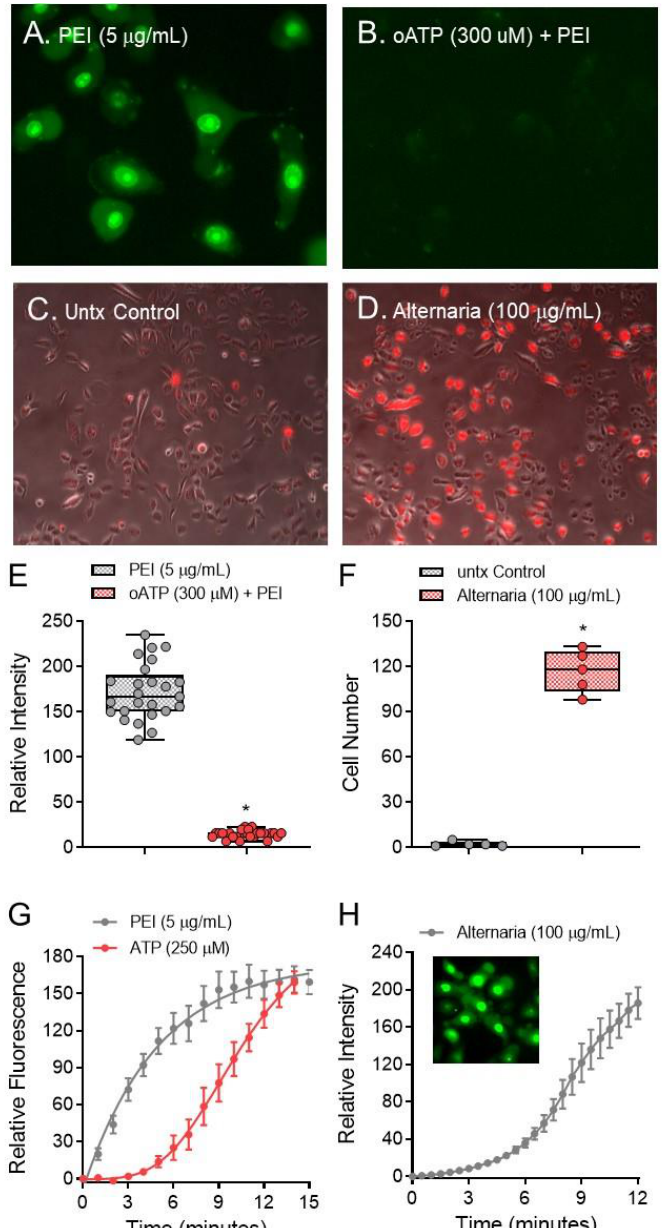
Figure 3. Yo Pro-1 and rhodamine uptake into hBE cells following treatment with PEI (5 µ g/mL) Figure 3. Yo Pro- 1 and rhodamine uptake into hBE cells following treatment with PEI (5 μg /mL) and Alternaria (100 µ g/mL). ( A ). Yo Pro-1 fluorescence detected in hBE cells after exposure to PEI and Alternaria (100 μg /mL). ( A ). Yo Pro-1 fluorescence detected in hBE cells after exposure to PEI for 15 min. ( B ). Pretreatment with oATP (300 µ M) blocks PEI-induced Yo Pro-1 uptake. ( C ). Control for 15 min. ( B ) . Pretreatment with oATP (300 μM) blocks PEI -induced Yo Pro-1 uptake. ( C ). Control experiment showing that hBE cells do not exhibit rhodamine uptake. ( D ). Alternaria (100 µ g/mL) experiment showing that hBE cells do not exhibit rhodamine uptake. ( D ) . Alternaria (100 μg /mL) stimulates rhodamine influx. ( E ). PEI (5 µ g/mL; n = 25) induced YoPro-1 uptake measured in units stimulates rhodamine influx. ( E ) . PEI (5 μg /mL; n = 25) induced YoPro-1 uptake measured in units of relative fluorescence intensity is blocked by oATP (300 μ M; n = 25; * p < 0.0001). ( F ). Rhodamine of relative fluorescence intensity is blocked by oATP (300 µ M; n = 25; * p < 0.0001). ( F ). Rhodamine uptake into a population of 150 hBE cells before and after Alternaria (100 μg /mL; n = 5 experiments) uptake into a population of 150 hBE cells before and after Alternaria (100 µ g/mL; n = 5 experiments) exposure (* p < 0.0001). ( G ) . Kinetics of PEI (5 μg /mL; n = 9) and ATP (250 μM; n = 10)-induced Yo exposure (* p < 0.0001). ( G ). Kinetics of PEI (5 µ g/mL; n = 9) and ATP (250 µ M; n = 10)-induced Yo Pro-1 uptake. ( H ) . Kinetics of Alternaria (100 μg /mL; n = 5) induced Yo Pro-1 uptake. Pro-1 uptake. ( H ). Kinetics of Alternaria (100 µ g/mL; n = 5) induced Yo Pro-1 PEI (5 μ g/mL; n = 55) also caused DNA fragmentation as revealed in comet assays that show significant ( † p < 0.0001) tail formation following exposure for 30 min (Figure 4). If cells were pretreated (1 h) with the ROS scavenger glutathione (5 mM; n = 70) or with inhibitors of ATP release (DIDS (100 μ M; n = 59) or 10 Panx (50 μ M; n = 67), DNA fragmen- tation was significantly (* p < 0.0001) blocked. Similarly, when PEI (5 μ g/mL) stimulated